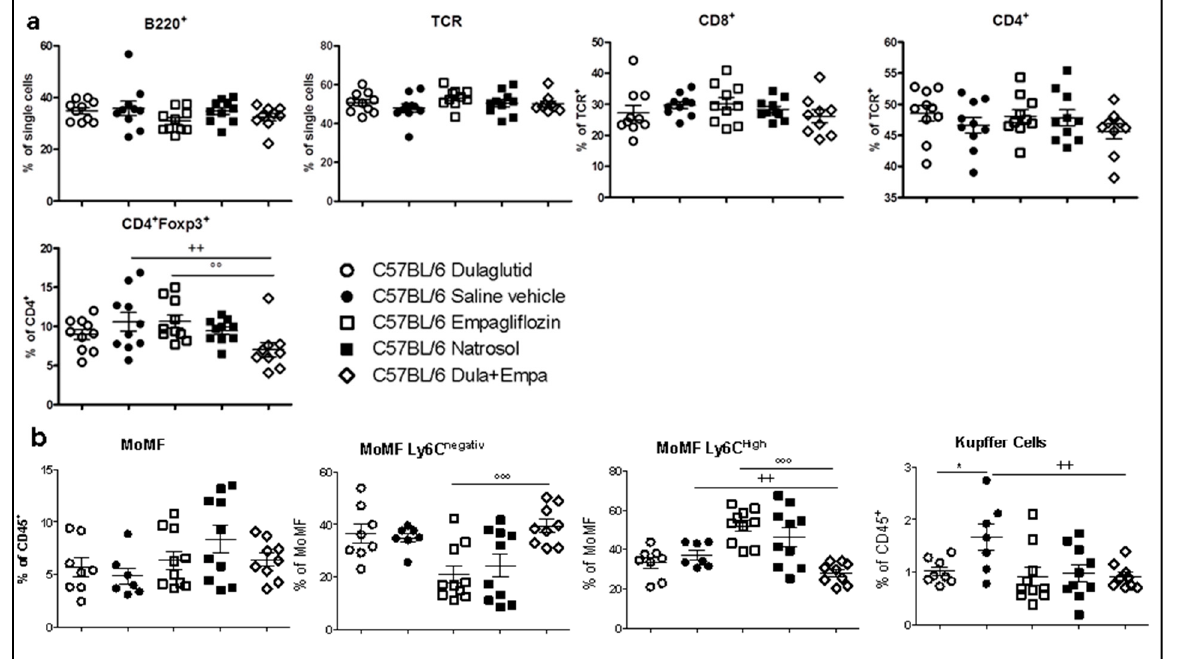
Figure 3. Flow cytometry analyses of the innate and adaptive immune system ( a ) Flow cytometry analyses of the adaptive immune system focusing on the intrahepatic subsets of CD4 + T cells and CD8 + T cells ( b ) Analyses of s of intrahepatic liver macrophages. Data are presented as mean ± SEM. Unpaired t -test with Welsh-correction was used for comparison between treatment and control group. C57BL/6 Dulaglutide: n = 10, C57BL/6 Saline vehicle: n = 10, C57BL/6 Empagliflozin: n = 10, C57BL/6 Natrosol: n = 10; C57BL/6 Dula + Empa: n = 9. * p < 0.05; ** p < 0.01; *** p < 0.001 was used for comparison of